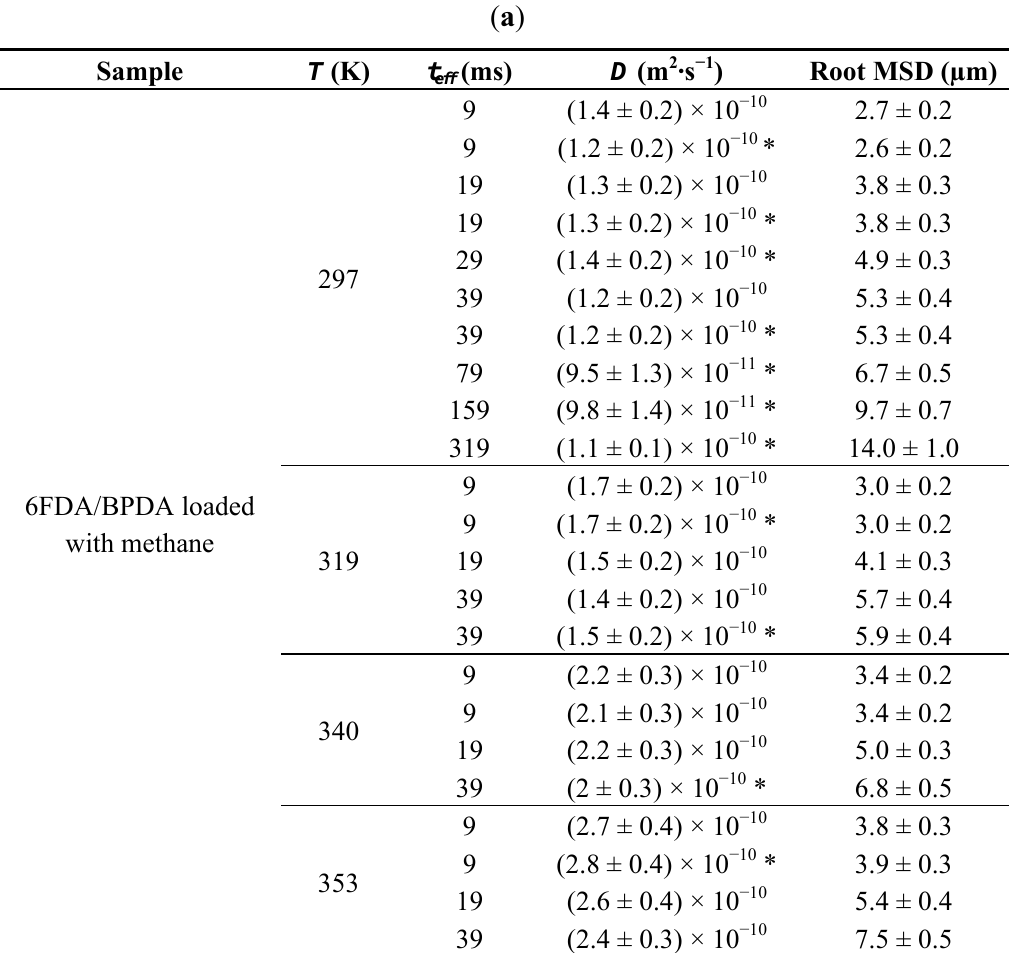
Table 1. Data for methane self-diffusion in: ( a ) 6FDA/BPDA, and ( b ) Matrimid Samples 1 and 2. Self-diffusion coefficients and the corresponding values of the root MSD were obtained from fitting PFG NMR attenuation curves measured for methane diffusion at different temperatures ( T ) and effective diffusion times ( t n = 1 and Equation (2). The data obtained by 13 C PFG NMR is labeled by (*). All other data was obtained by 1 H PFG